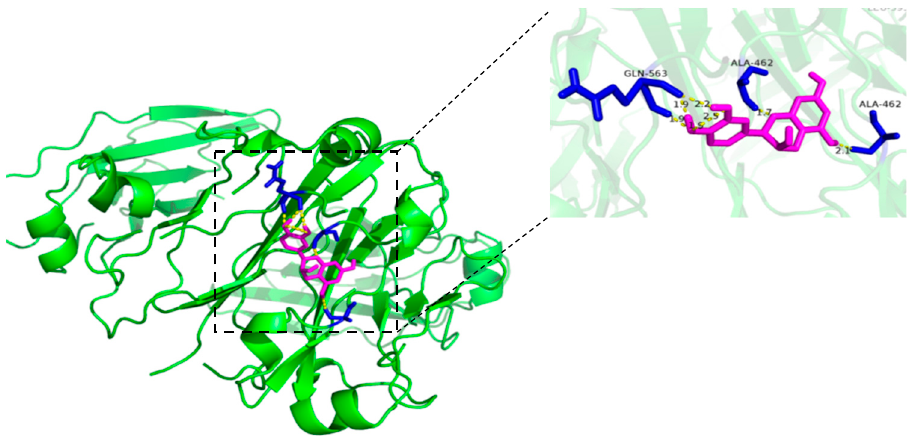
Figure 1. Molecular docking diagram of the catechin and IgY interaction.